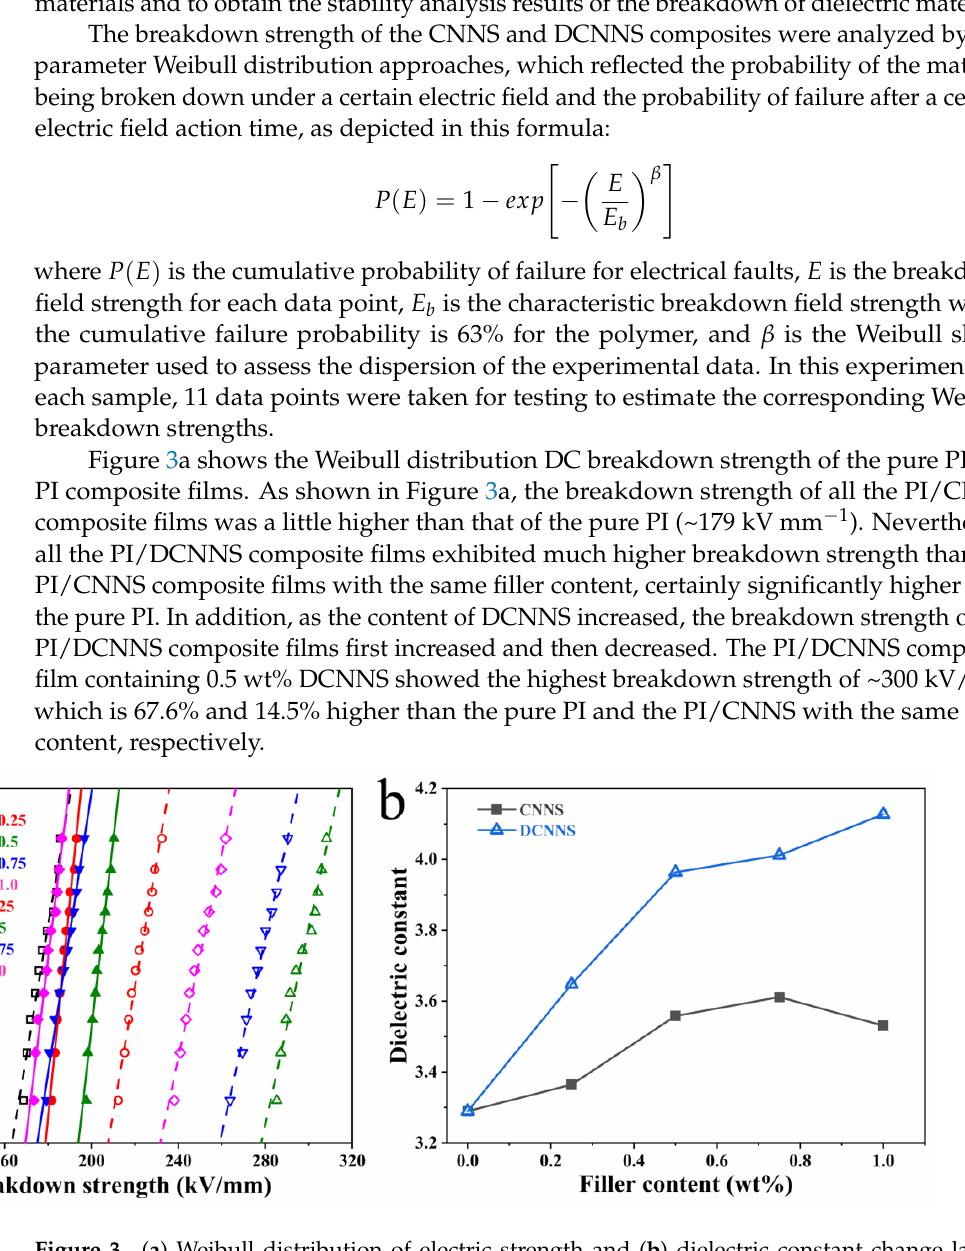
Figure 3. ( a ) Weibull distribution of electric strength and ( b ) dielectric constant change law of PI composites.